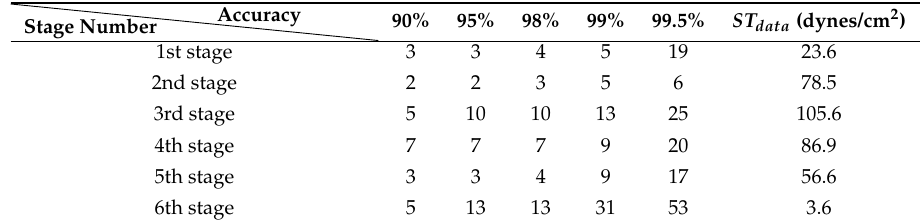
Table 4. The minimum number of modes required to reach a specified reconstruction accuracy in wall shear stress (WSS) data is shown for the cerebral aneurysm model. The spatiotemporal average of data ( ST data ) is shown for each stage.